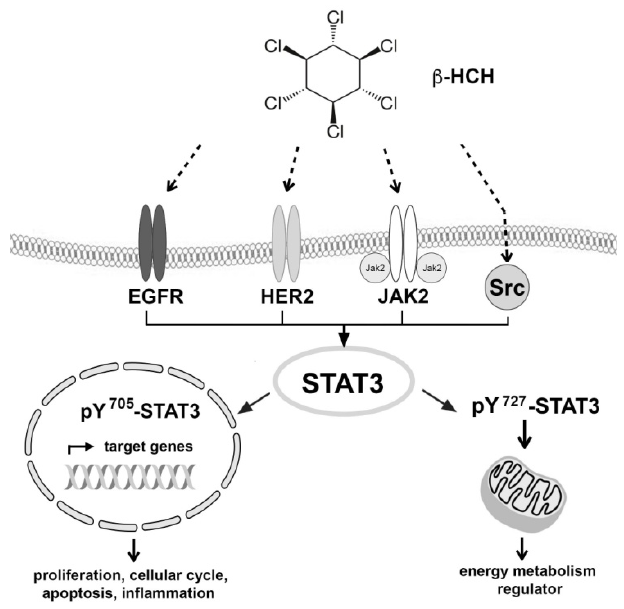
Figure 9. The central role of STAT3 as a hub protein in signaling pathways triggered by β‐ HCH.